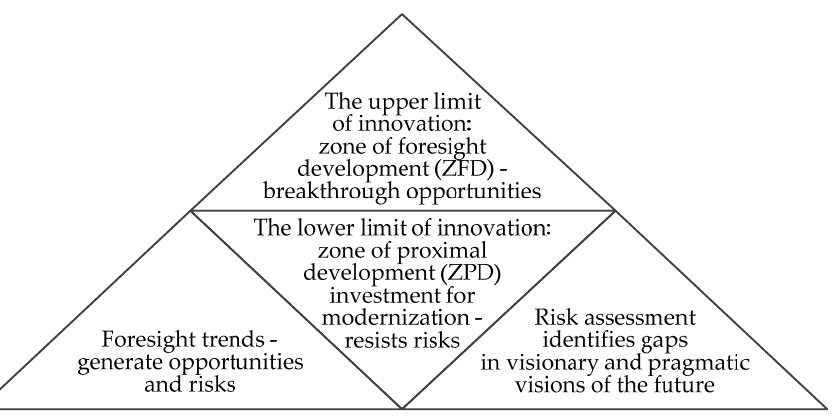
Figure 4. The pyramid of boundaries of innovation in foresight in the MAYA methodology.